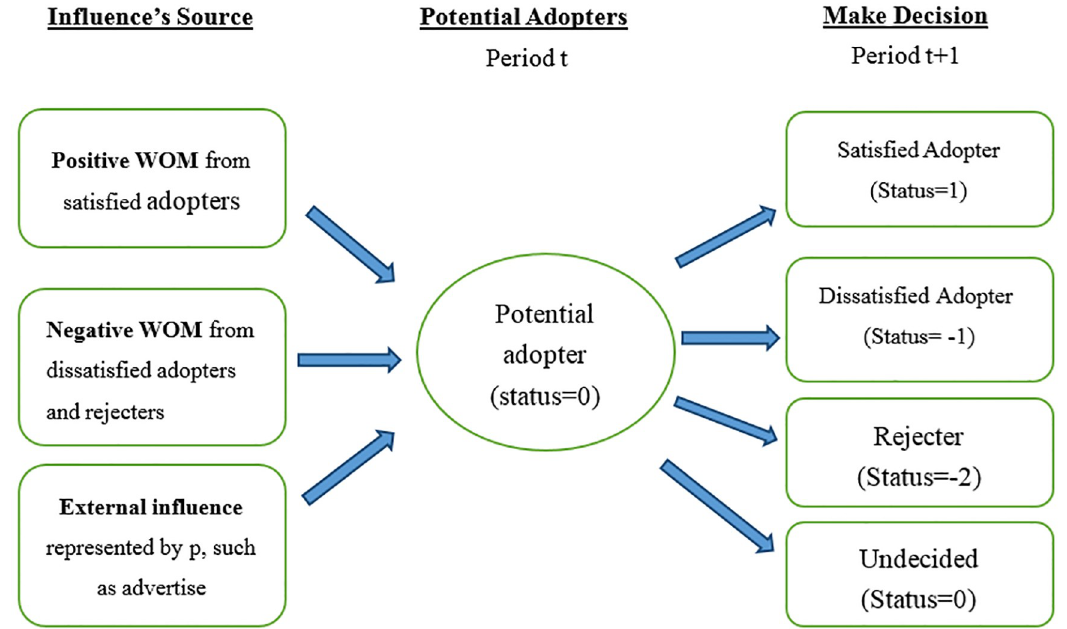
Fig 1. Decision making of potential consumers and the influences of WOM. Potential adopters are influenced by advertisement, and positive and negative WOMs. Each agent would be in one of the following states: the satisfied adopter, the dissatisfied adopter, the rejecter and the undecided